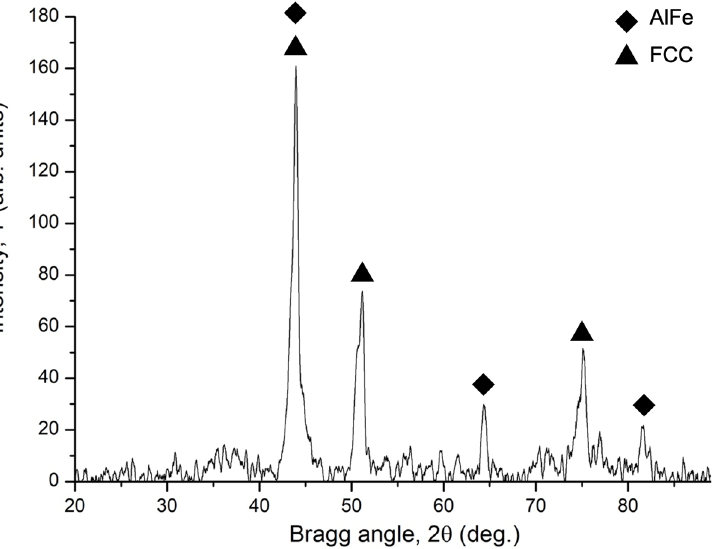
Figure 2. X-ray diffraction pattern of Al-Co-Cr-Fe-Mn-Ni coating fabricated by WAAM onto AA5083 substrate.